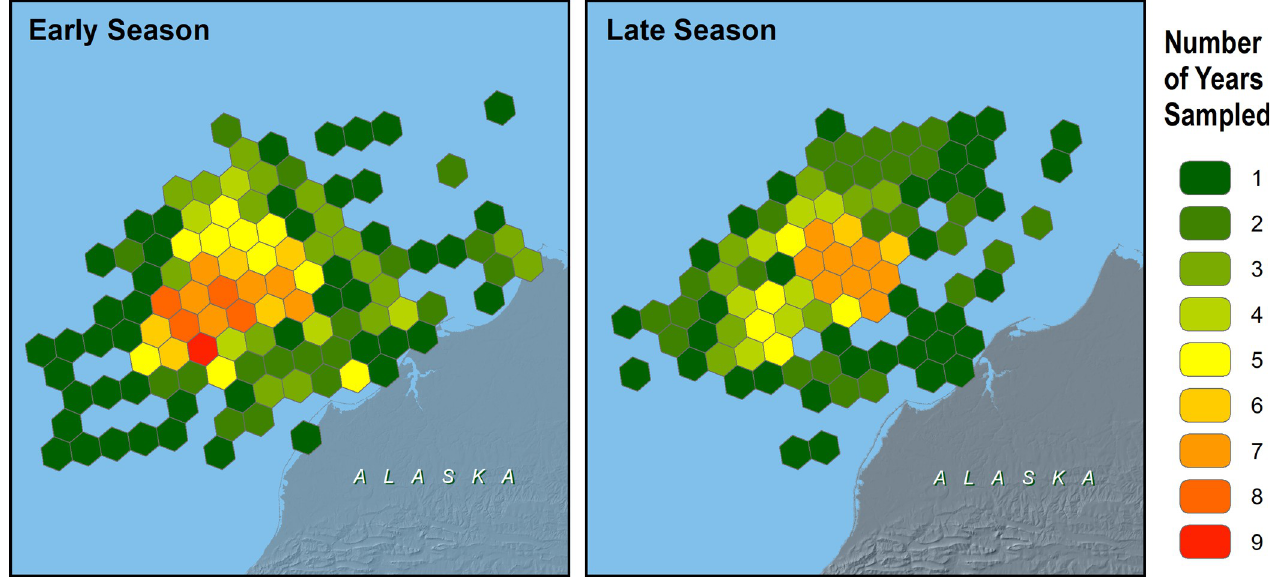
Fig 2. Seasonal and interannual differences in sampling effort in the northeastern Chukchi Sea, 2008–2018.